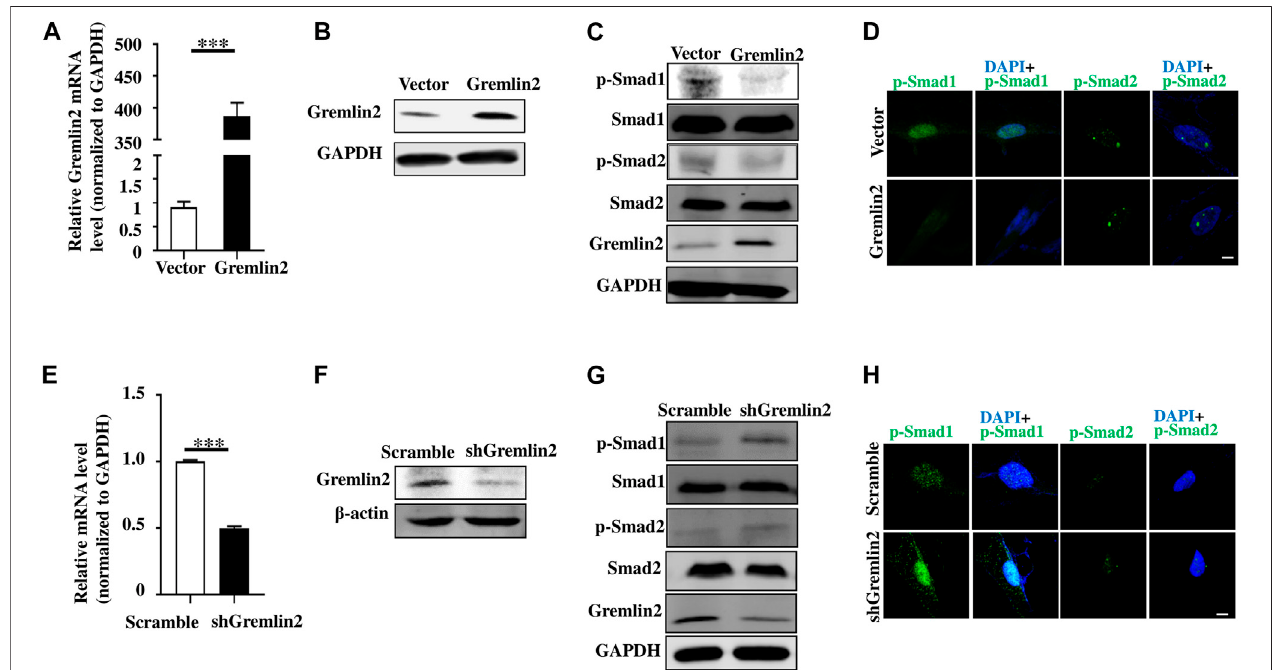
FIGURE7| Gremlin2regulates fi broblastactivationthroughtheTGF- β /BMPsignalingpathway. (A) ThemRNAlevelofGremlin2afterHFL-1cellsweretransfectedwith Gremlin2 or empty-load plasmid for 24 h. (B) The expression level of Gremlin2 after HFL-1 were transfected with Gremlin2 or empty-load plasmid for 72 h detected using western blotting. (C) Detection of the p-Smad1 and p-Smad2 in the control group and fi broblasts overexpressing Gremlin2, Smad1 and Smad2 were used as the overall control group. (D) Expression level of p-Smad1 and p-Smad2 in the control group and fi broblasts overexpressing Gremlin2 using immuno fl uorescence. Green representsp-Smad1andp-Smad2,andbluerepresentsDAPI(nucleus).Scalebar (cid:2) 5µm. (E) ThemRNAexpressionofGremlin2afterHFL-1cellsweretreatedwithshRNA ofGremlin2for24 h,andthecontrolgroupwasinfectedwithplko.1no-loadviruswithoutthetargetgene,andthecorrespondingmRNAexpressionlevelwasstandardizedto thatofGAPDH. (F) ProteinconcentrationinthecellswasdetectedusingwesternblottingwithactinasthequantitativeindicatorproteinandGremlin2asthetargetprotein. (G) Expressionlevelofp-Smad1andp-Smad2inthecontrolgroupandtheGremlin2knockdownHFL-1cellswithSmad1andSmad2astheoverallcontrol. (H) Theexpression of p-Smad1 and p-Smad2 in the control group and Gremlin2 knockdown fi broblasts, and the expression level of target antigen. Green represents p-Smad1 and p-Smad2 and blue represents DAPI (nucleus). Scale bar (cid:2) 5 m. *** p < 0.001, Student ’ s t-test bilateral was used to analyze. Experiments were repeated three